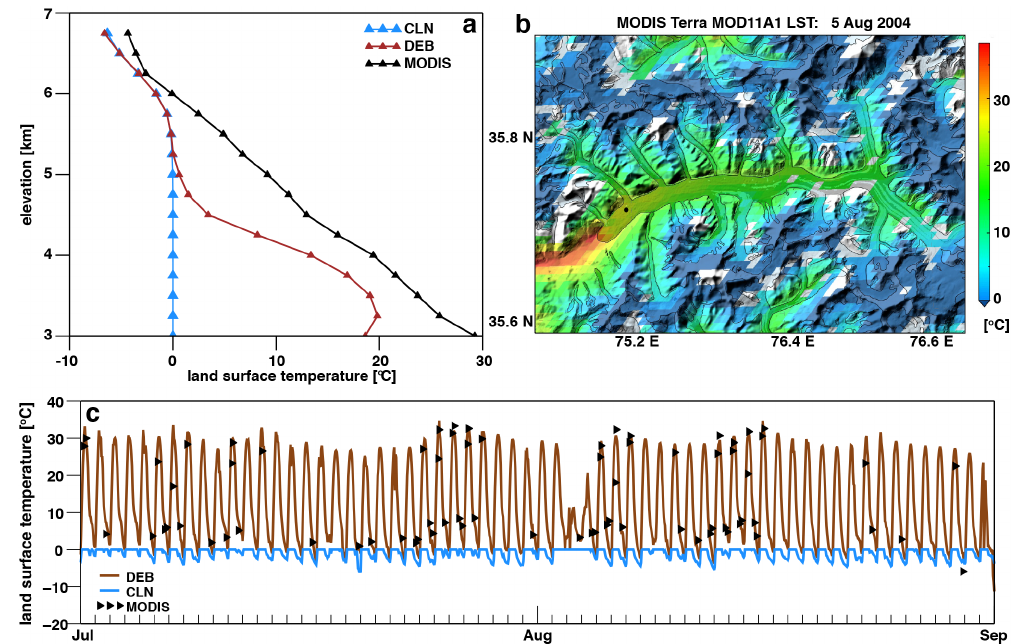
Figure 3. (a) Mean elevational profiles of daytime land surface temperature (LST) from DEB, CLN and composite MODIS Terra MOD11A1/Aqua MYD11A1 data sets, averaged from 1 June to 1 September 2004 and in 250m elevation bins over glacierized pixels in WRF. (b) A sample time slice of MODIS Terra LST from 5 August 2004 on its native grid, overlaid on the Baltoro glacier outline and debris-covered area. (c) Time series of LST from 1 July to 1 September 2004 from the same data sets as in panel (a) , taken from a pixel on the Baltoro tongue, which is denoted by a black circle in panel (b) . The unit for all plots is ◦